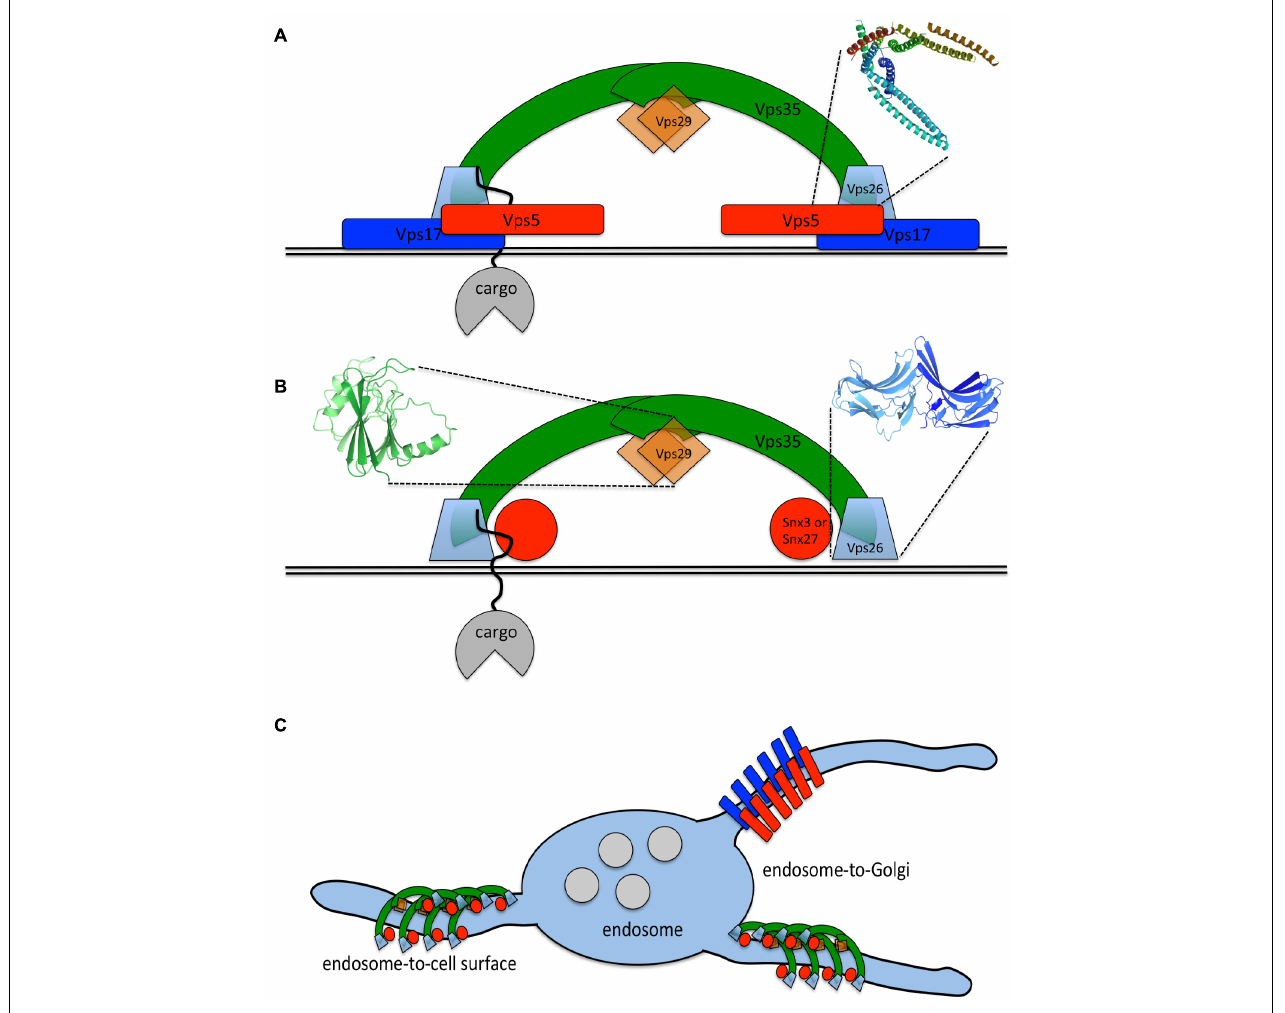
FIGURE 1 | The retromer complex in simple or higher eukaryotes. (A) In a simple eukaryote such as yeast, the retromer complex is a stable heteropentamer that associates with endosomal membranes to sort cargo proteins (e.g., Vps10p) into tubules for endosome-to-Golgi retrieval. The Vps26 protein (along with Vps35p) plays a key role in cargo recognition but Grd19p (SNX3) also contributes to sorting specific cargo. The BAR domain (PDB:4FZS) of SNX-BAR proteins such as Vps5p and Vps17p adopts a curved conformation and can tubulate membranes. (B) In mammals, there is no stable association between the retromer trimer